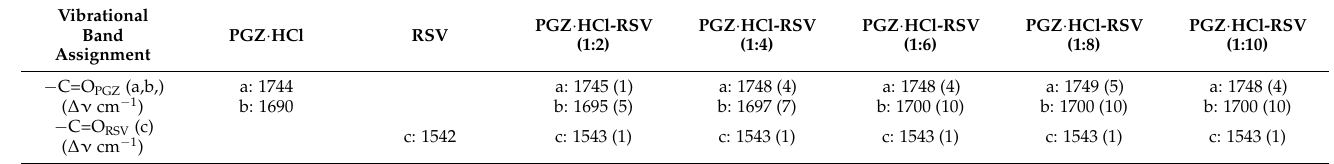
Table 4. Vibrational band assignment of the solid forms of PGZ · HCl-RSV at different stoichiometric ratios (1:1, 1:2, 1:4, 1:6, 1:8, and